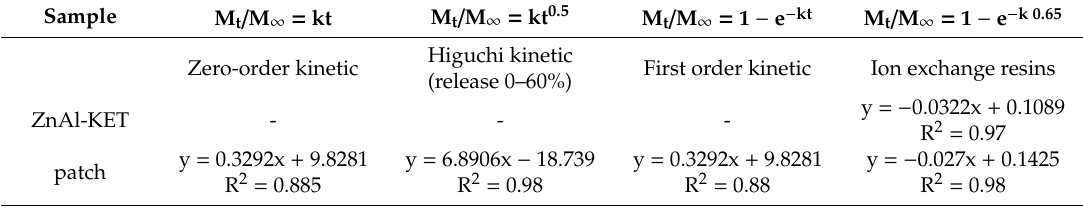
Table 3. Equations and R 2 values obtained by the application of the kinetic mathematical models (zero-order, first-order) and ion exchange resins for loaded patch and ion exchange resins for ZnAl-KET. Sample M t / M ∞ = kt M t / M ∞ = kt 0.5 M t / M ∞ = 1 − e − kt M t / M ∞ = 1 − e − k 0.65 Higuchi kinetic First order kinetic Ion exchange resins Zero-order kinetic (release 0–60%) y = − 0.0322x + 0.1089 ZnAl-KET - - - R 2 = 0.97 y = 0.3292x + 9.8281 y = 6.8906x − 18.739 y = 0.3292x + 9.8281 y = − 0.027x + 0.1425 patch R 2 = 0.885 R 2 = 0.98 R 2 = 0.88 R 2 =